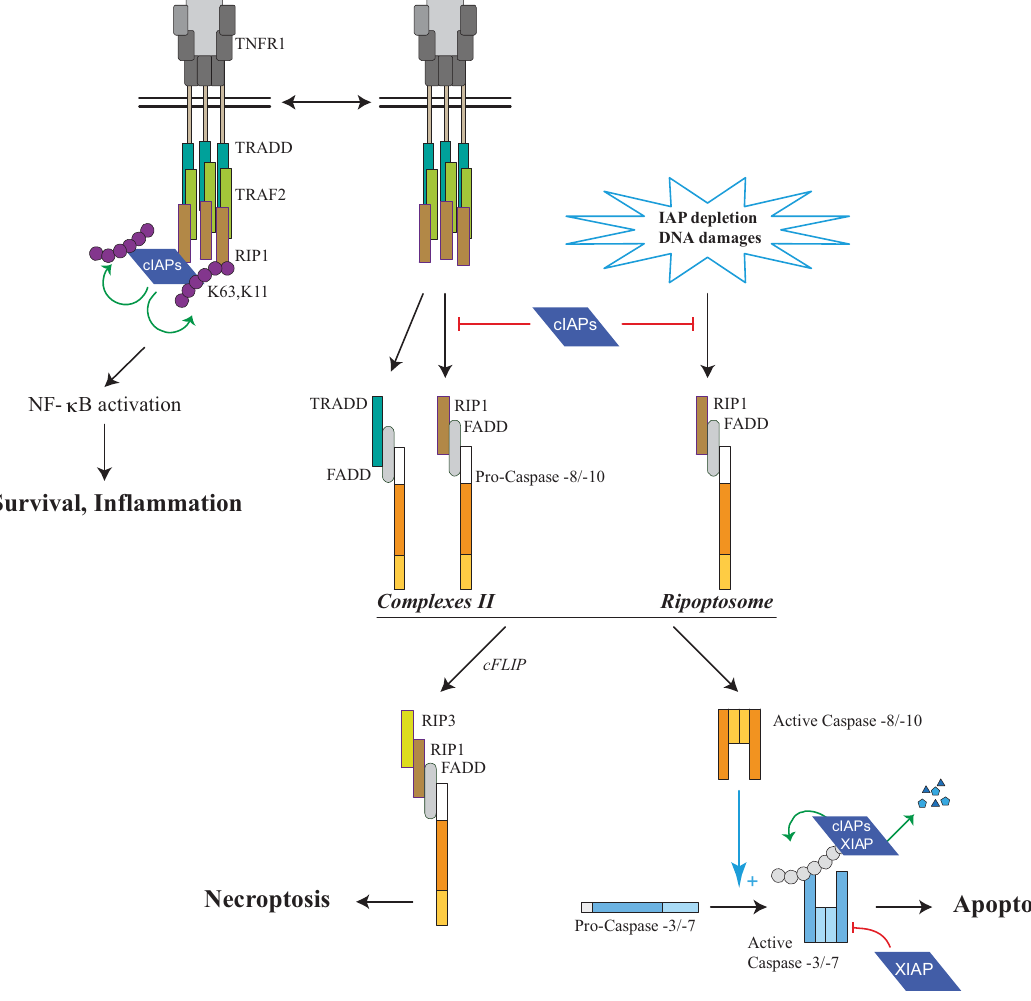
Figure 4. Regulation of RIP1-containing platforms by IAPs. Tumor Necrosis Factor Receptor 1 (TNFR1) stimulation induces the recruitment, to the receptor, of cIAPs and Receptor interacting protein 1 (RIP1) via the adaptors TNFR1-associated Death domain (TRADD) and TNFR associated factor (TRAF2). cIAPs trigger K63 self-ubiquitination and K11 and K63-ubiquitination of RIP1 leading to NF-(cid:2)B activation and survival. In the absence of cIAPs, a secondary RIP1-containing cytoplasmic complex is formed (complex II) leading to cell death. A cytoplasmic RIP-1-containing complex named RIPoptosome can also be assembled, in the absence of Death Receptor stimulation, after DNA-damage- mediated IAP depletion or the use of synthetic IAP antagonists known to induce IAP degradation. RIP1-containing platform can lead to either caspase-8 or -10 activation and apoptosis, or caspase-independent cell death referred to as Necroptosis. Initiator caspases-8 or -10 induce the activating proteolytic processing of effector caspase-3 or -7 responsible for apoptosis. IAPs can control cell death at different levels: (1) cIAPs can induce the K63 and K11 ubiquitination of RIP1 allowing NF-(cid:2)B activation and preventing the formation of complex II or RIPoptosome; (2) cIAPs and XIAP can induce K48-ubiquitination of RIP1 leading to its proteasomal degradation. (3) XIAP can directly inhibit the activity of processed effector caspase-3 or -7; (4) cIAPs and XIAP can induce ubiquitination and proteasome-mediated degradation of processed forms of caspase-3 or